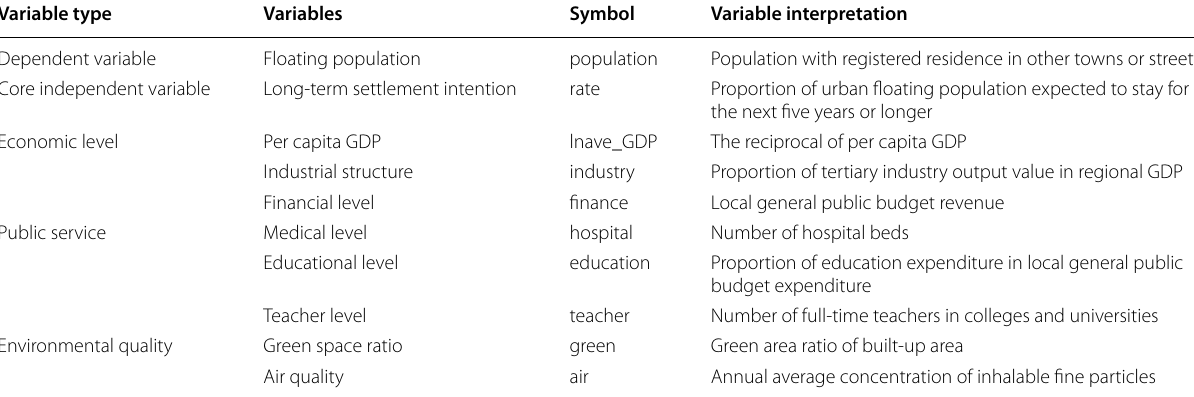
Table 1 Selection and description of